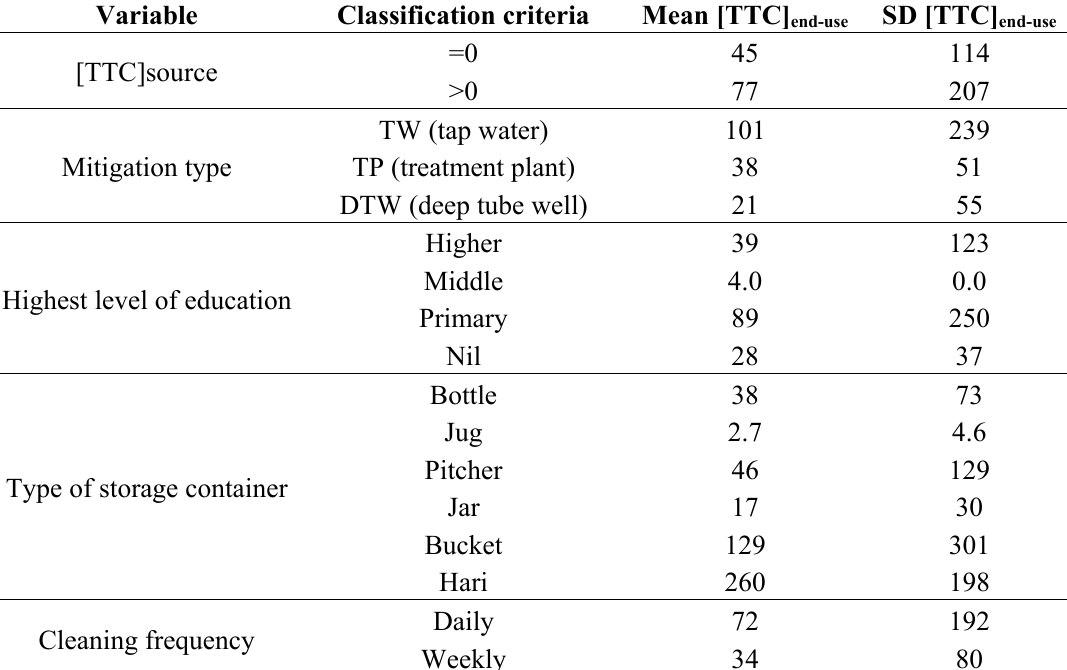
Table 4. [TTC] classified by independent or predictor end-use